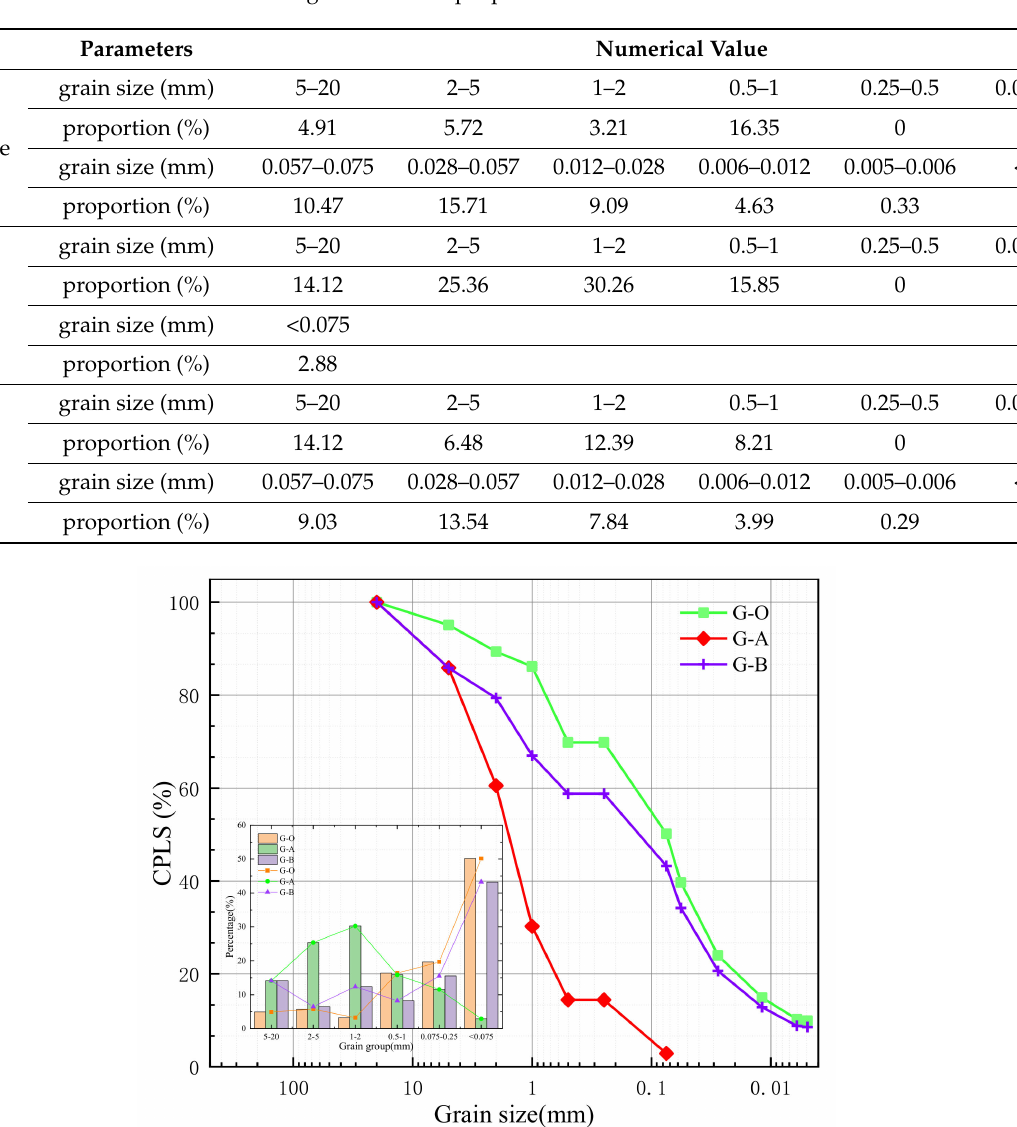
Table 2. Percentage table of sample particle size distribution.